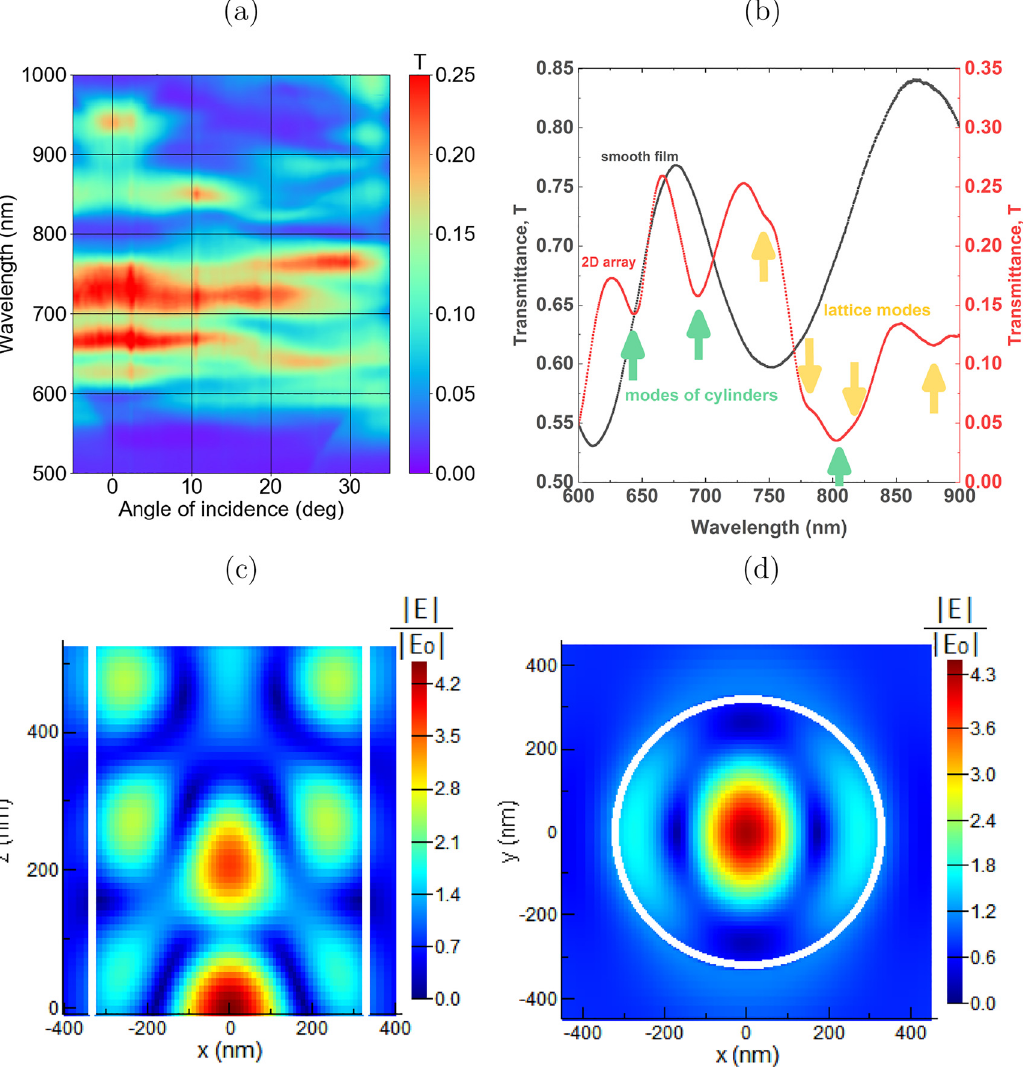
Figure 2: Near- and far-field optical properties of 2D nanocylinder array. (a) False-color plot for the experimental dependence of the transmittance on the light incidence angle and wavelength for the structure with d = 650 nm; (b) experimental transmittance spectra of the smooth film (black) and the array of cylinders (red) with d = 650 nm (the green (yellow) arrows indicate the dips corresponding to the excitation of the (lattice modes) eigenmodes). (c and d) False-color plots for the spatial distributions of light electric field value | E | at the excitation of the localized mode at 𝜆 = 800 nm in (c) x − z and (d) x − y